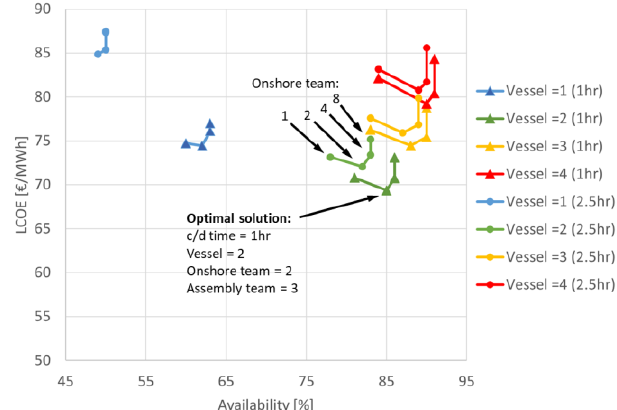
Fig. 31. LCOE versus availability, with various numbers of vessels and 2 alternative c/d times. In each coloured line, four different numbers of onshore teams are considered (=1,2,4,8).